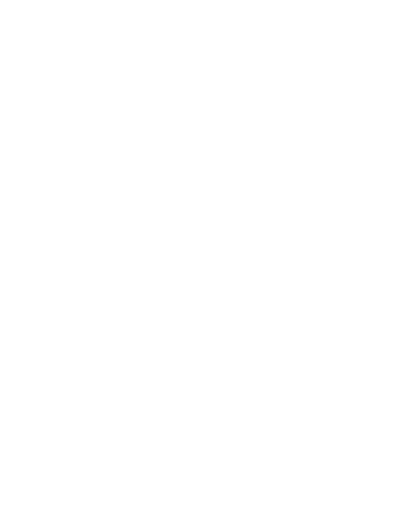
Table 1. The main parameters of the Karbala